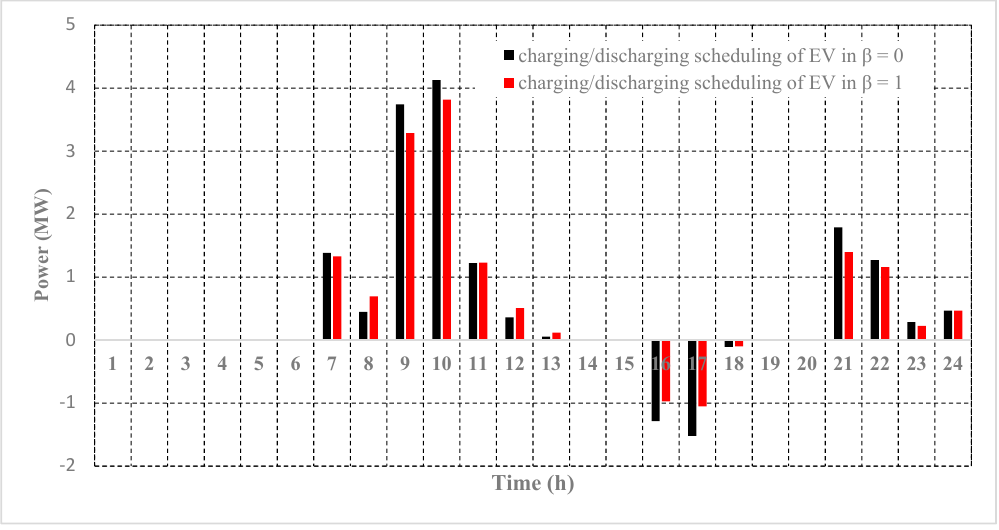
Figure 7 . Charging/discharging scheduling of 500 EVs. Figure 7. Charging/discharging scheduling of 500 EVs.